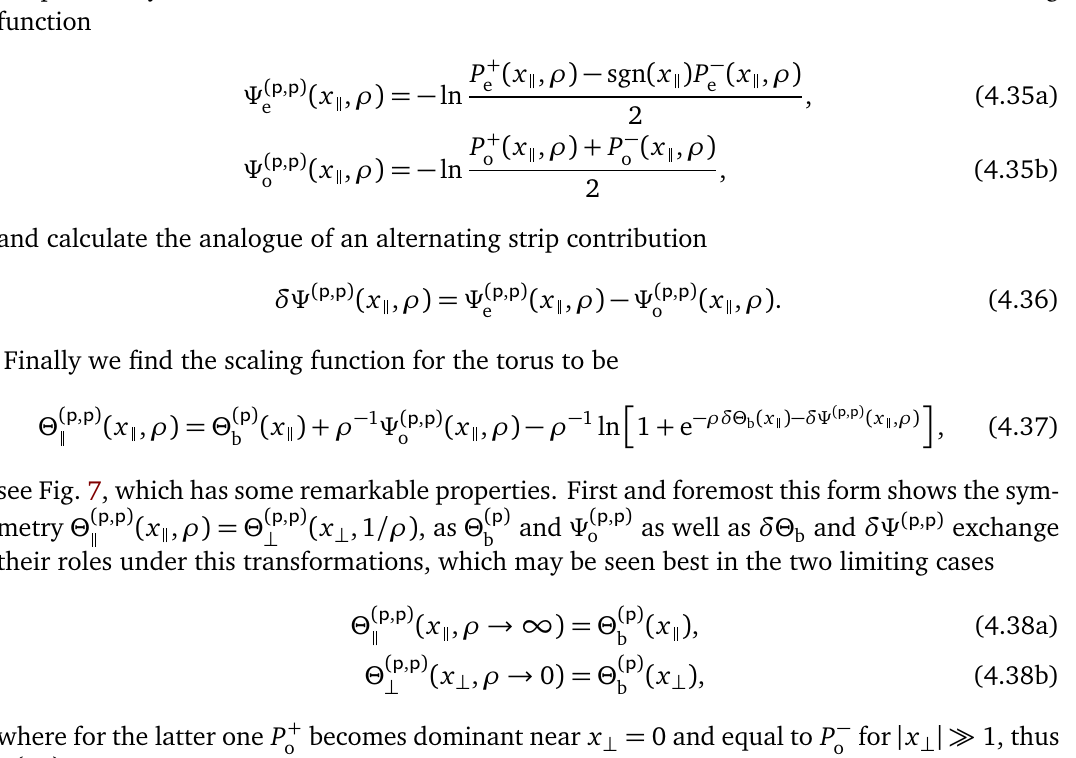
( p , p ) ( x ρ ) = Θ ( p , p ) ( x /ρ ) . (cid:107) , ⊥ ,1 ⊥ (cid:107)